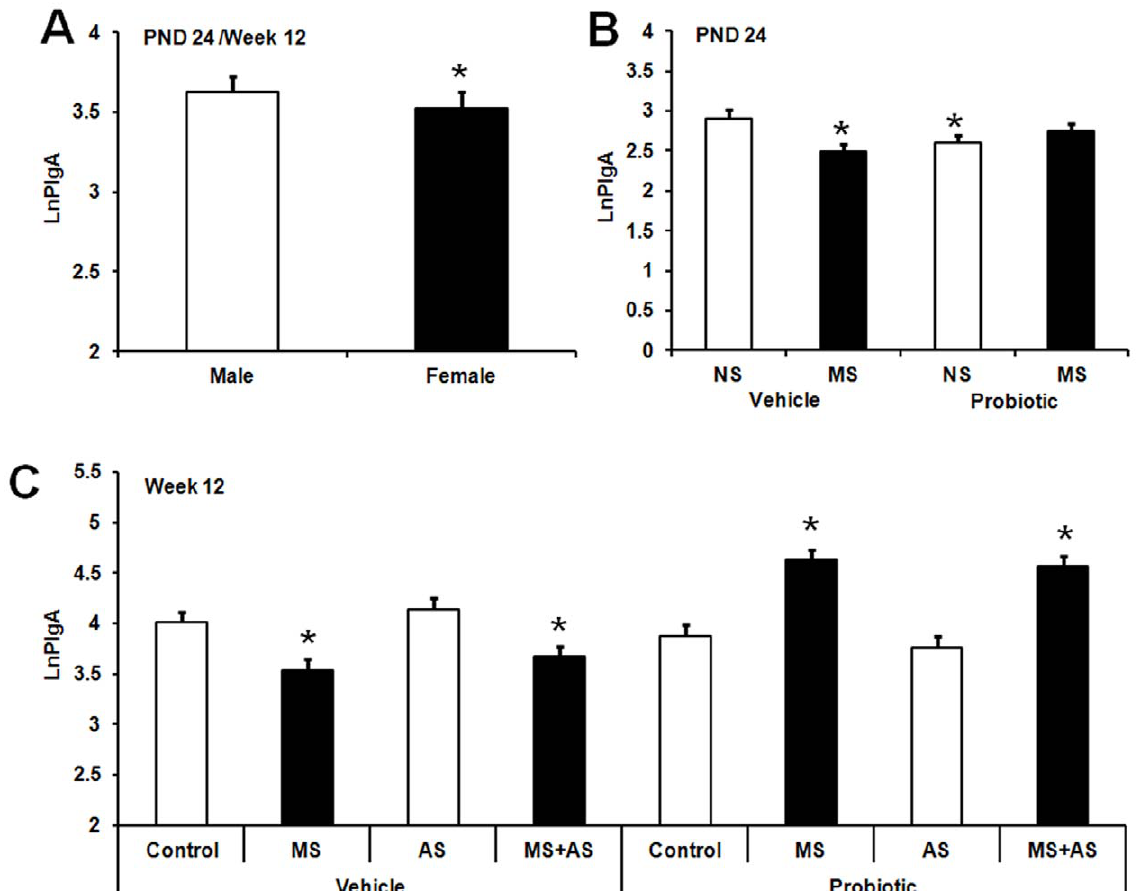
Figure 4. Effect of maternal probiotic intervention, stress, and gender on plasma IgA levels. A ) Effect of sex on Ln-transformed plasma IgA concentrations (LnPIgA, least squares means + SE) in rats. The figure presents aggregated data across test days (PND 24 and 86). Initial IgA data were expressed as m g/mL plasma. The hollow bar represents males (n=109) and the filled bar represents females (n=117). An asterisk (*) indicates statistical significant difference ( p # 0.05). B ) Effect of maternal probiotic intake and neonatal maternal separation (MS) on Ln-transformed plasma IgA concentrations (LnPIgA, least squares means + SE) in rats at PND 24. The hollow bars represent animals exposed to no-MS (NS): NS vehicle (n=15), NS probiotic (n=19). The filled bars represent animals exposed to MS: MS vehicle (n=19), MS probiotic (n=20). An asterisk (*) indicates statistical significant difference relative to vehicle NS animals ( p # 0.05). C ) Effect of maternal probiotic intake, neonatal maternal separation (MS) and adult restraint stress (AS) on Ln-transformed plasma IgA concentrations (LnPIgA, least squares means + SE) in adult rats. Hollow bars represent no-stress control animals or those exposed to adult stress (AS): control vehicle (n=21), AS vehicle (n=20), control probiotic (n=17), AS probiotic (n=17). Filled bars represent MS or MS + AS animals: MS vehicle (n=20), MS + AS vehicle (n=20), MS probiotic (n=18), MS + AS probiotic (n=19). An asterisk (*) shows significant difference compared to control animals in the vehicle subset ( p # 0.05).